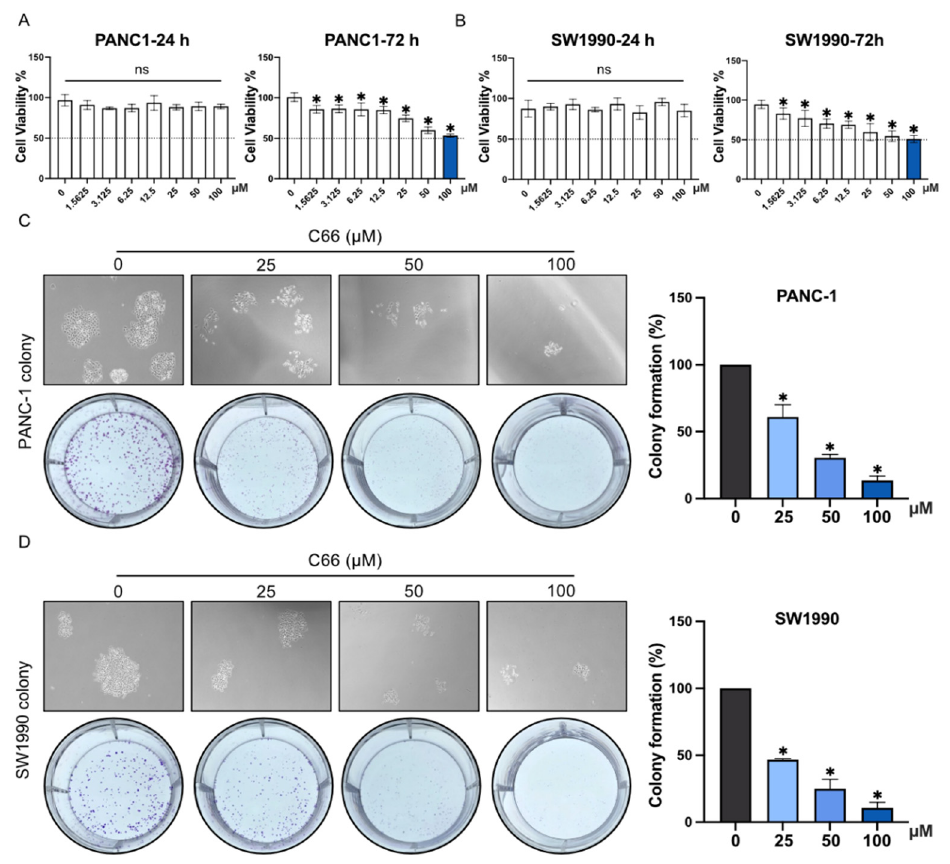
Figure 3. Inhibition of pancreatic cancer cell proliferation by C66. ( A , B ) PANC-1 and SW1990 proliferation was determined by CCK-8 assay after the treatment with C66 (0, 1.5625, 3.125, 6.25, 12.5, 25, 50, or 100 μ M) for 24 or 72 h. Each bar represents mean ± SEM of three independent experiments. n = 3, * p < 0.05, compared with the matching control; ns = not significantly different, compared with the matching control. ( C , D ) PANC-1 and SW1990 colony formation after the treatment with C66 (25, 50, or 100 μ M) administered for 7 days. Each bar represents mean ± SEM of three independent experiments. n = 3, * p < 0.05, compared with the matching control.